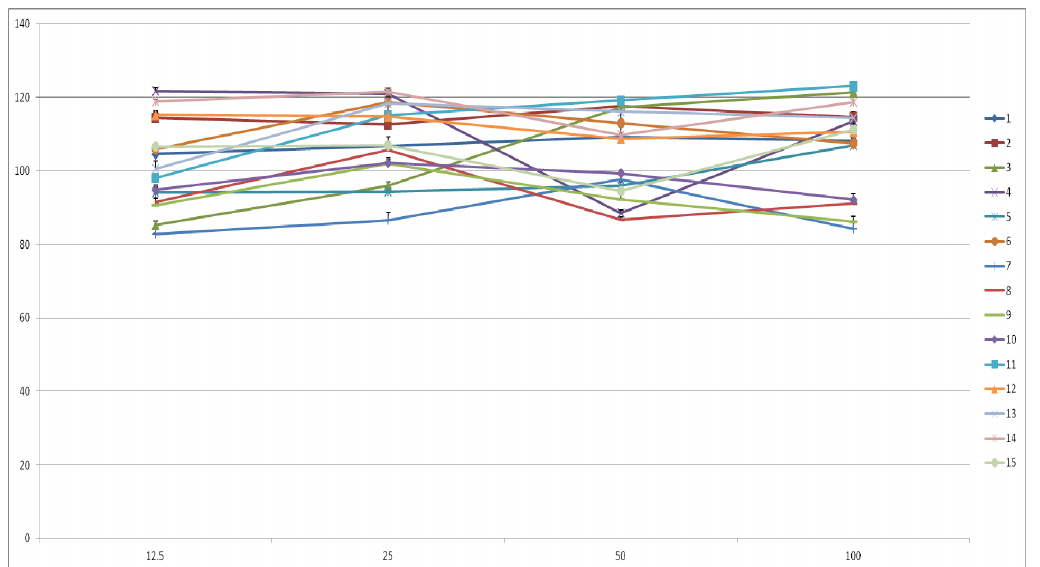
Values represent means ± S.D. of three determinations. Values bearing different superscripts in the same column are significantly different ( p < 0.05). Figure 2. Cell viability of compounds 1 – 15 from CL on RAW 264.7 cell